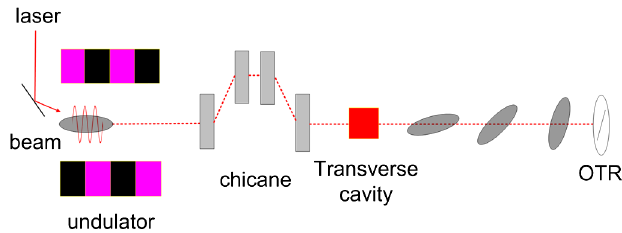
FIG. 4. Schematic of the all-optical time-resolved measure- ment of laser energy modulation.